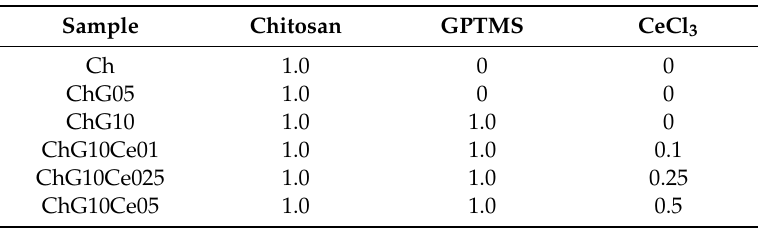
Table 1. Starting compositions of spheres (molar